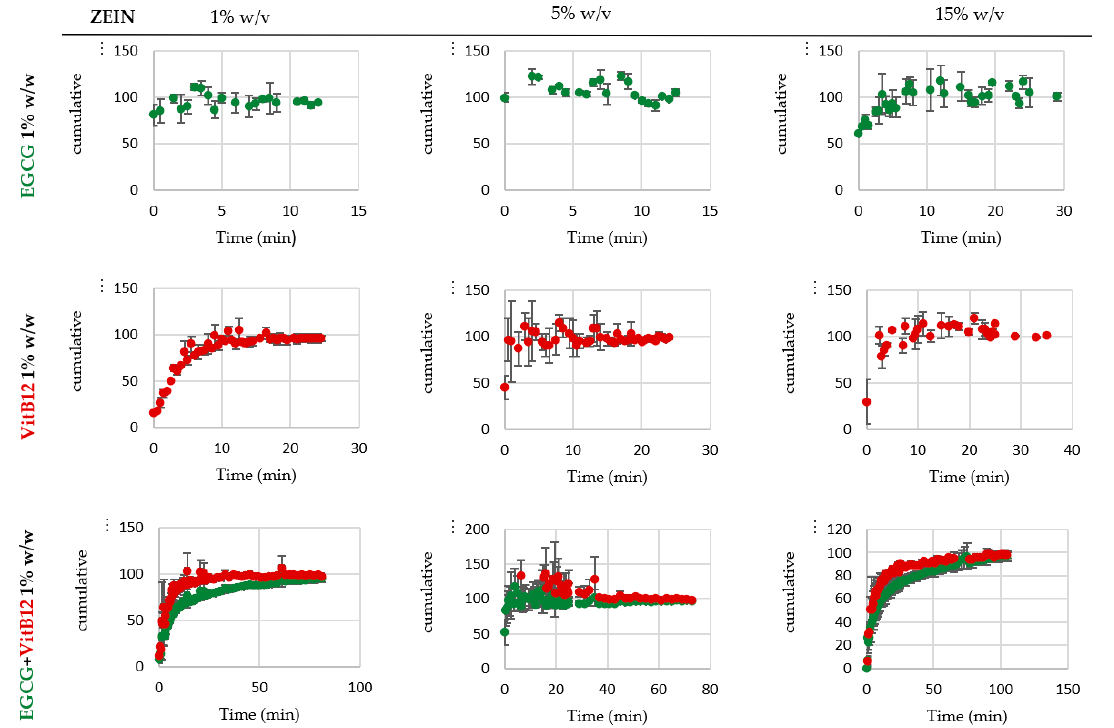
Figure 3. In vitro release profiles, % of EGCG/VitB12/(EGCG+VitB12) normalized by the total amount released, in H 2 O of the microstructures (electrospinning) loaded with 1% w / w of active compounds and 1%, 5% and 15% w / v zein.